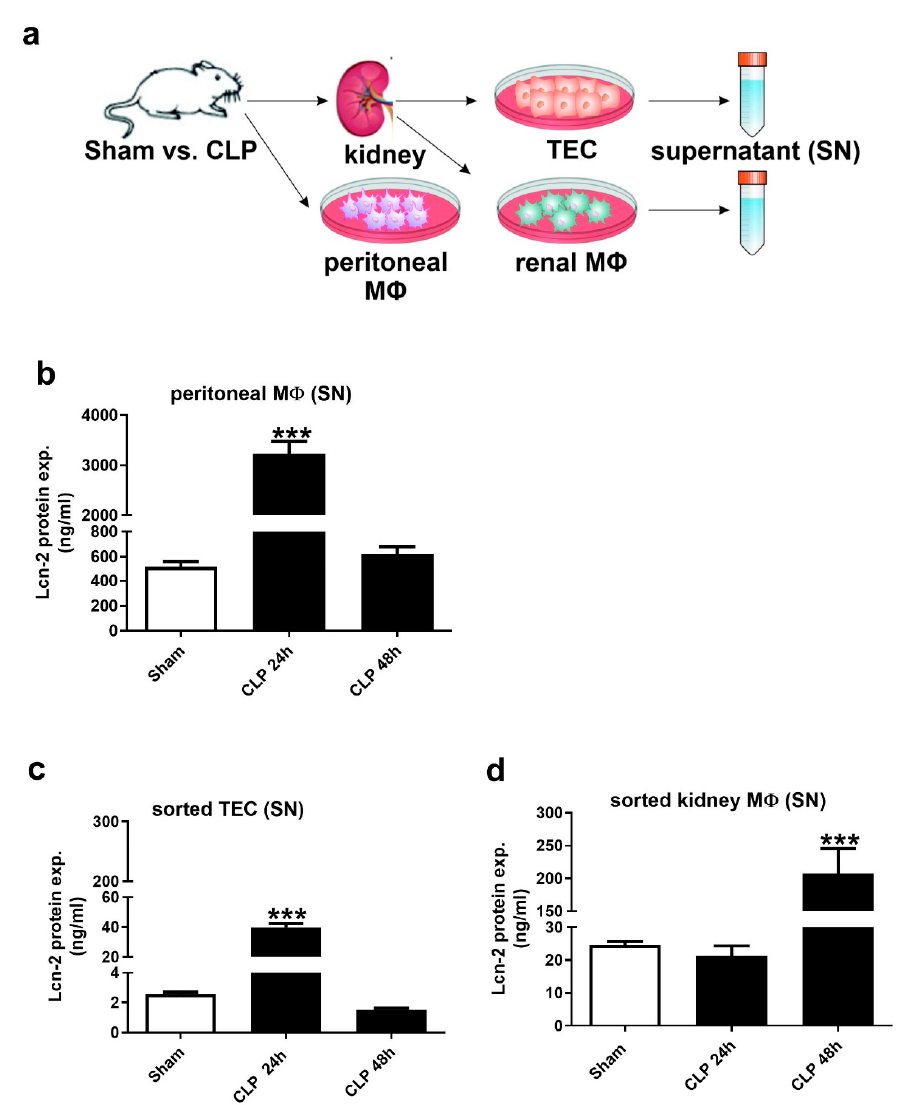
Figure 2. Lcn-2 is expressed from different sources during CLP-induced renal injury progression. ( a ) Schematic representation for the isolation of both macrophages (M Φ ) and tubular epithelial cells (TEC). ( b – d ) ELISA of Lcn-2 protein expression in the supernatant of short-term cultured and freshly isolated (b) peritoneal M Φ , (c) TEC, and (d) renal M Φ . n = 6 isolated primary peritoneal M Φ , TEC, and renal M Φ per group, *** p < 0.001; One-way ANOVA followed by Tukey’s multiple comparison test.